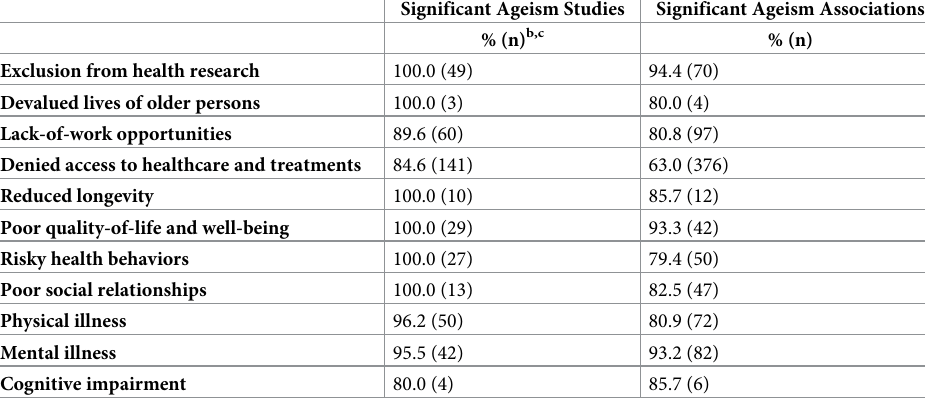
Table 1. Evidence of ageism as indicated by significant studies and significant associations across 11 health domains a